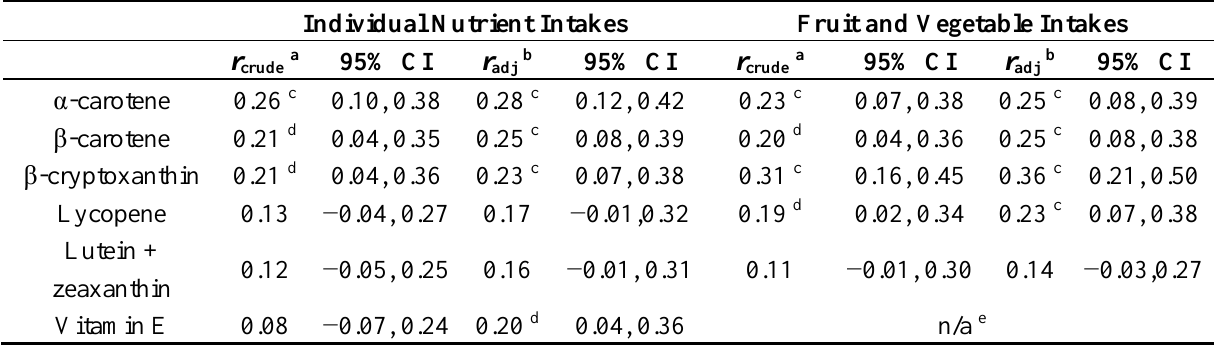
Table 2. Correlations and 95% CI between FFQ estimated intakes and biomarkers.